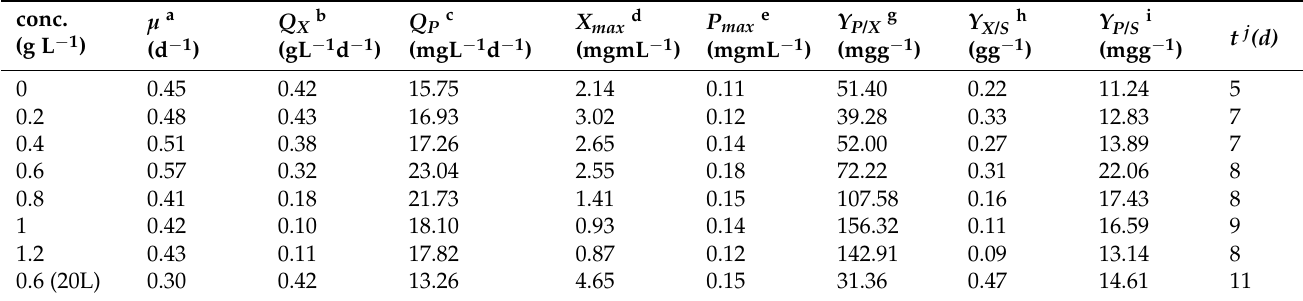
Table 1. Fermentation parameters of the batch experiments in a 5 L and a 20 L stirred tank bioreactor under different culture conditions.